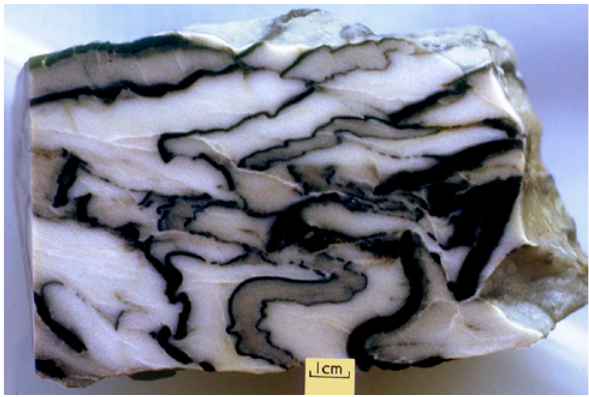
Figure 35. Discordant, ruptured, and re-healed fold patterns occur in this multi layered quartz vein from the Laurentian Shield, near Sudbury in Canada. This plastic deformation is consistent with a polymeric amorphous silica precursor in the vein before crystallisa- tion, but it would remain difficult to explain if it is contended that the vein formation was by “crystallisation from hydrothermal solu- tion” and then subsequent folding of the crystalline quartz. In this type of random discordant folding, analysis of the stress fields that cause the folding, shows it to be isotropic or fluid deformation. Any deformation pattern in a solid phase must be anisotropic.